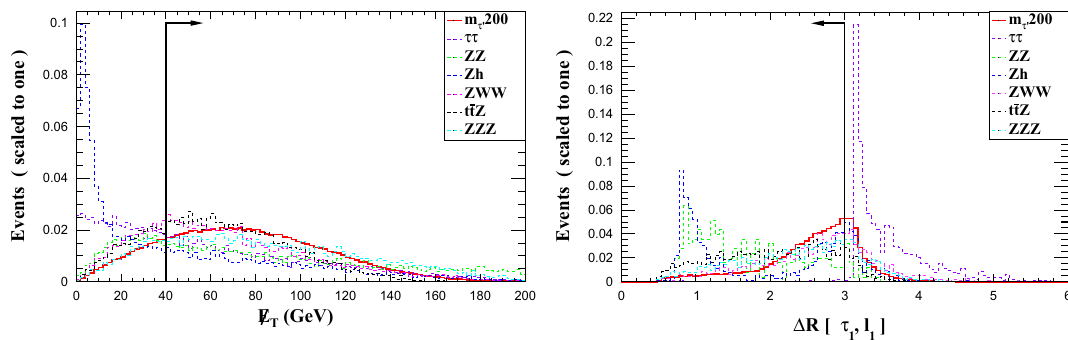
√ s = 500 GeV. The solid lines stand for signal events,